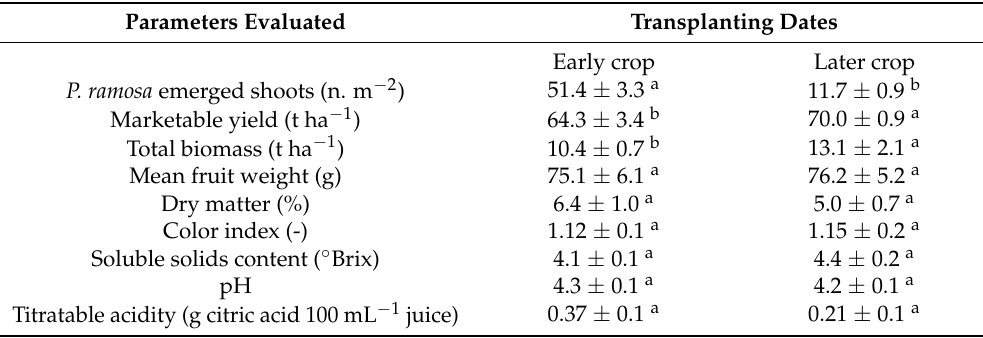
Table 1. Mean values of emerged branched shoots of Phelipanche ramosa and quanti-qualitative traits of the tomato fruit for the early and late crops at harvesting.